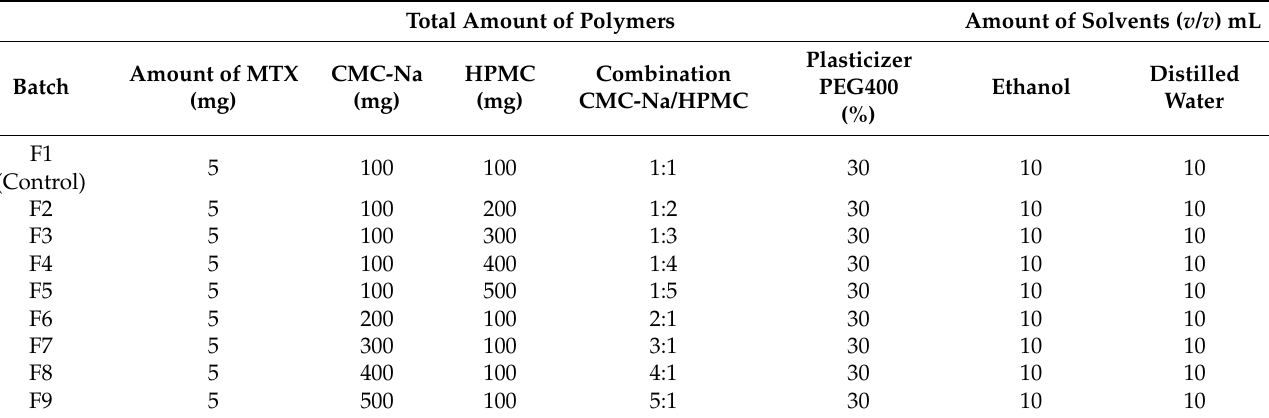
Table 1. Composition of methotrexate transdermal patches.